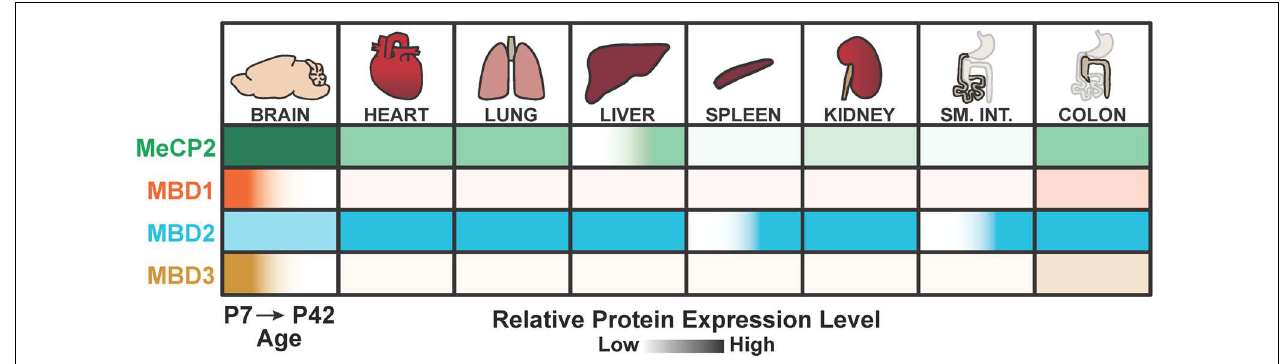
FIGURE 7 | Summary of MeCP2, MBD1, MBD2, and MBD3 spatiotemporal expression patterns. MBD2 is expressed throughout the body with lower relative expression in the brain compared to other MBD proteins at postnatal day 7 (P7) and postnatal day 42 (P42). MBD2 is also up regulated temporally in the adult spleen and small intestine. In contrast, MeCP2 is most highly expressed in the brain. MBD1 and MBD3 are highly expressed in the brain at early ages, but down regulated in the adult brain. Adapted from Wood et al.